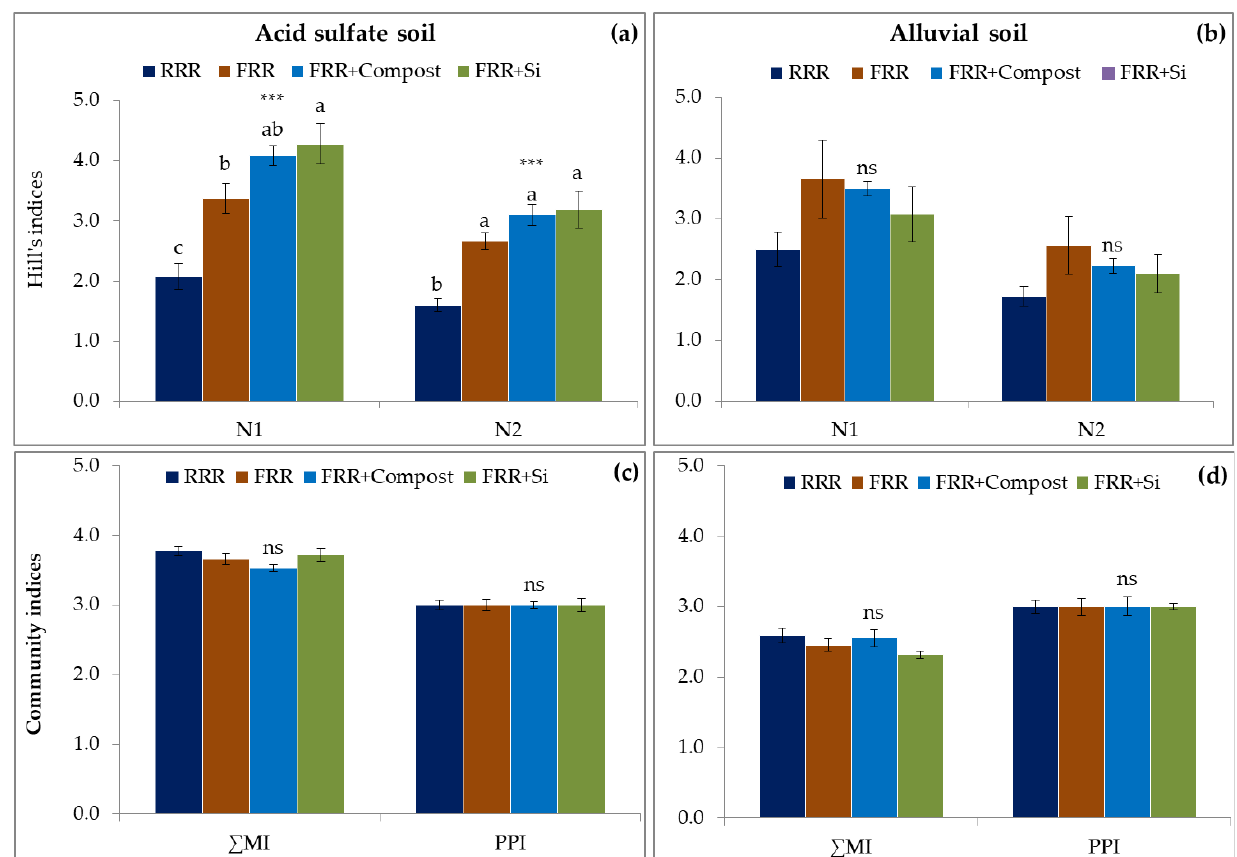
Figure 4. The diversity indices (Hill’s indices) and community indices (total maturity indices ∑ MI and plant-parasitic index (PPI) (mean ± standard error, n = 4) of nematode community among treatments in acid sulfate soil ( a , c ) and alluvial soil ( b , d ) in Ben Tre province and Kien Giang province, Vietnam, respectively. The different letters indicate the significant differences among treatments at *** p < 0.001; ns, not significant. RRR, triple–rice system; FRR, fallow and double–rice; FRR + Compost, fallow and double–rice with 3 Mg ha –1 sugarcane filter cake compost; FRR + Si, fallow and double–rice with 100 kg ha –1 silicate fertilizer.